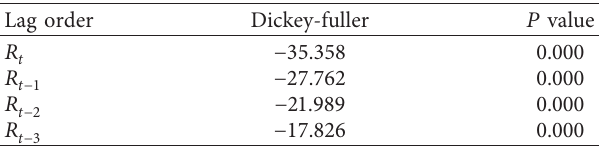
Figure 3: Daily logarithmic return rate of the Shanghai Composite Index. Table 3: ADF inspection